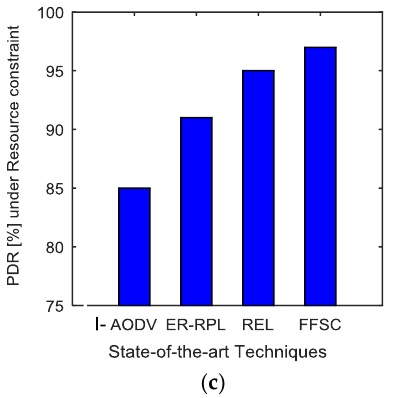
Figure 6. Simulation based evaluation results: ( a ) network lifetime in number of communication rounds; ( b ) percentage of nodes alive during the entire simulation time; ( c ) packet delivery ratio in resource constrained environments.